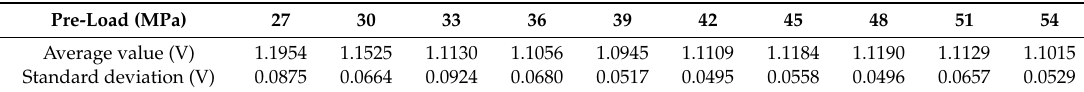
Figure 5. The signal voltages acquired from smart washer. Table 1. The average and standard deviation of the focused signal (V) with pre-load 0–24 MPa.